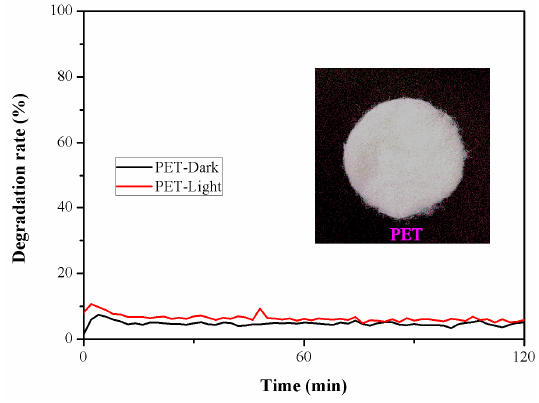
Figure 10. Controlled test of catalyst carrier under light and dark conditions.